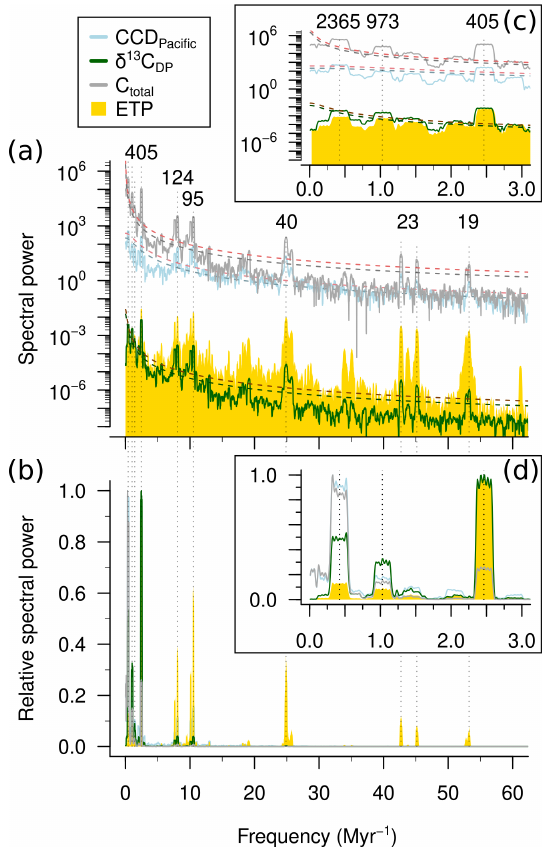
Figure 3. MTM spectral analysis of LOSCAR model output with orbital forcing strength α = 0 . 5 and noise level 0.2. Shown are the model tracers and the ETP forcing used on absolute (a) (log axis) and normalized (b) (linear axis) spectral power. Relative spectral power was calculated by dividing each value by their maximum value. Insets (c) and (d) are the same as (a) and (b) but zoomed in on the frequency axis. Periods of interest (kyr) are labelled and indicated with dashed